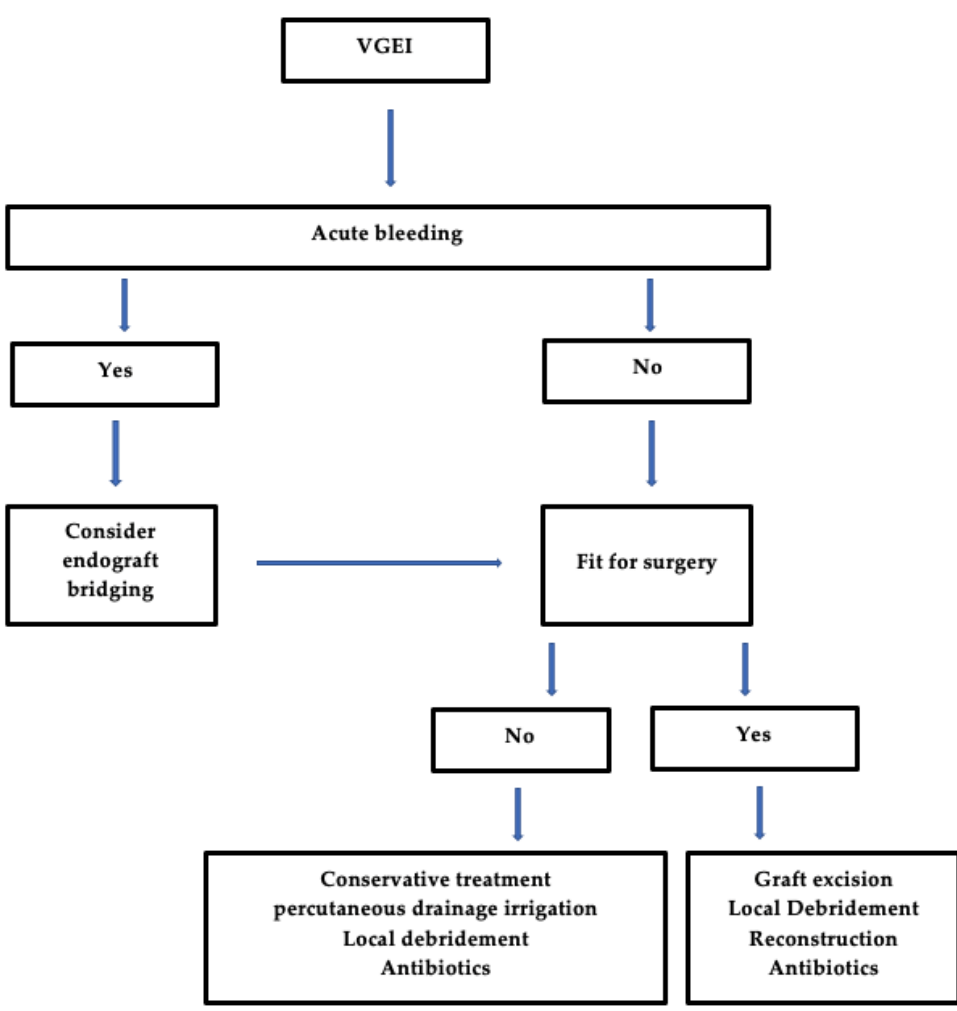
Figure 6. General Algorithm for the management of VGEI. VGEI = vascular graft or endograft infec- tion.